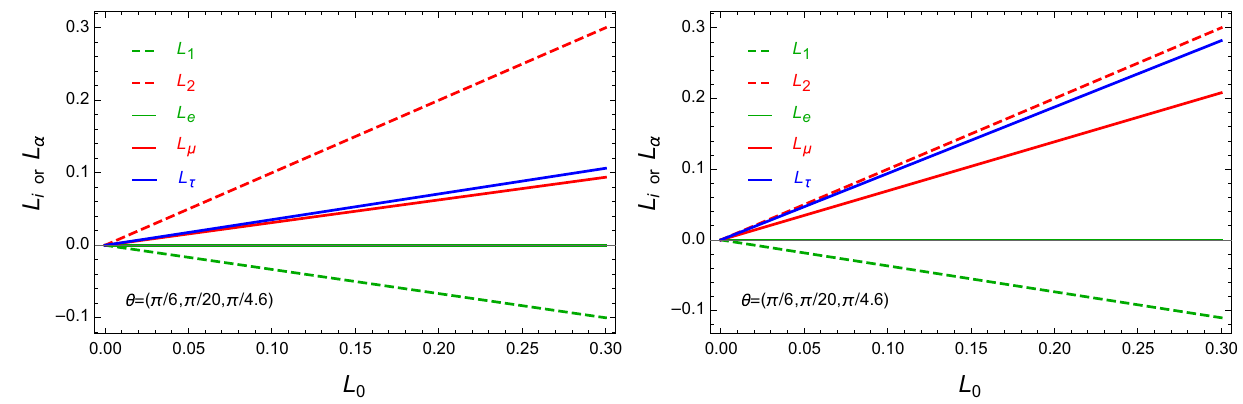
ples of L m leading to L e ≈ 0 satisfying BBN constraint. Left L m = diag ( L 1 , L 2 , L 3 ) = ( − t 2 L 0 , L 0 , 0 ) . Right L m = diag ( − ( t 2 12 / c 2 ) L , L , L ) t 2 0 0 0 13 12